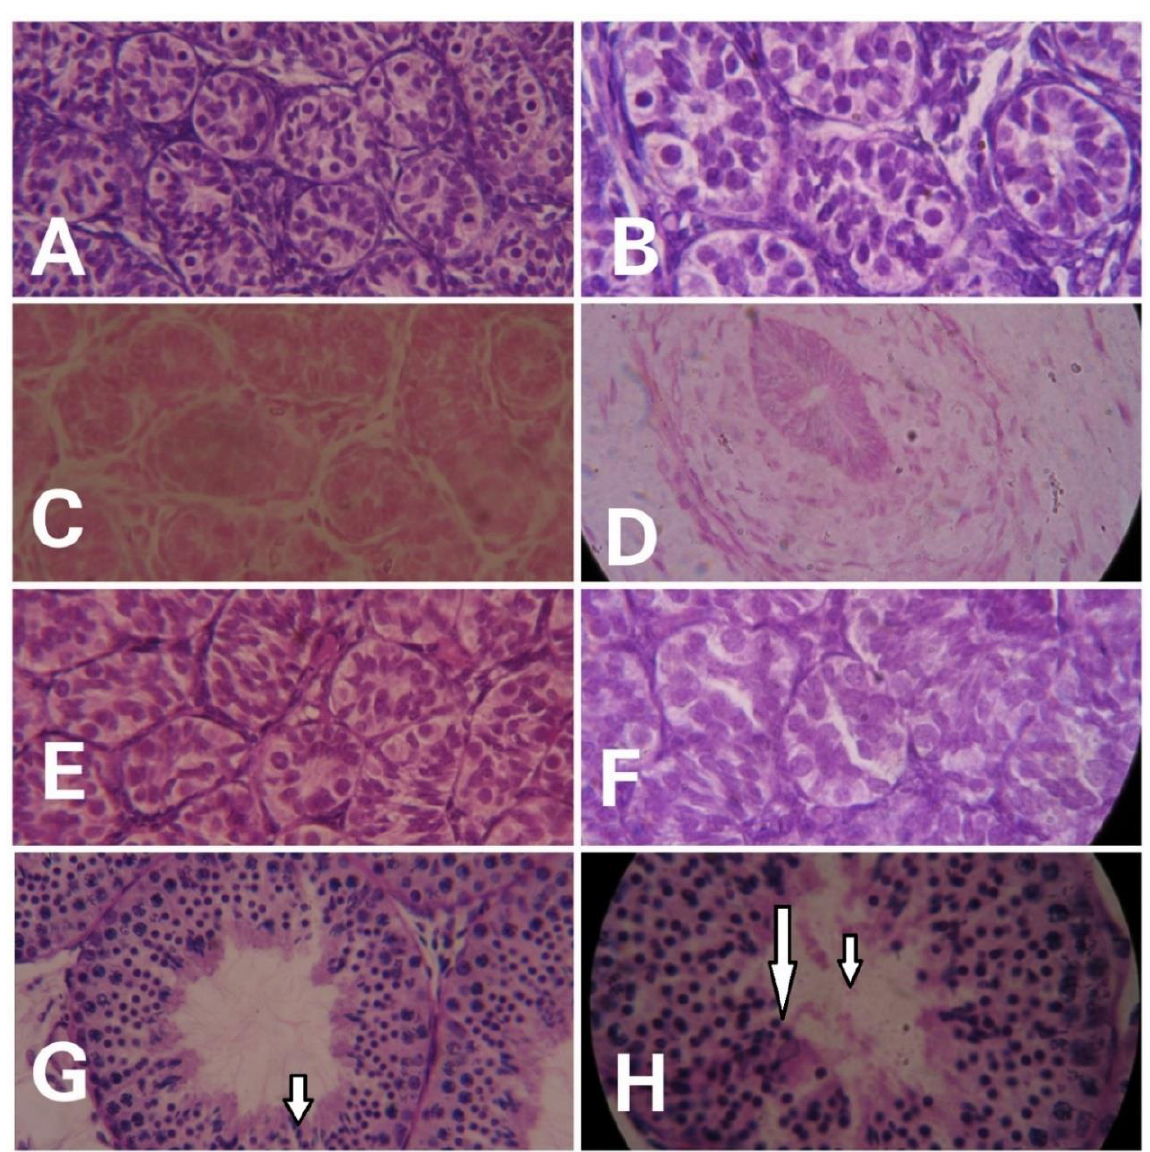
Figure 2. Representative photomicrographs showing the testicular histology of infants (( A ) = 40×, ( B ) = 100×), juvenile (( C ) = 40×, ( D ) = 100×), prepubertal (( E ) = 40, ( F ) = 100×), and adult (( G ) = 40×, ( H ) = 100×) male rhesus monkeys. Active spermatogenesis (indicated by arrows) and a wide lumen is evident in adult monkeys.